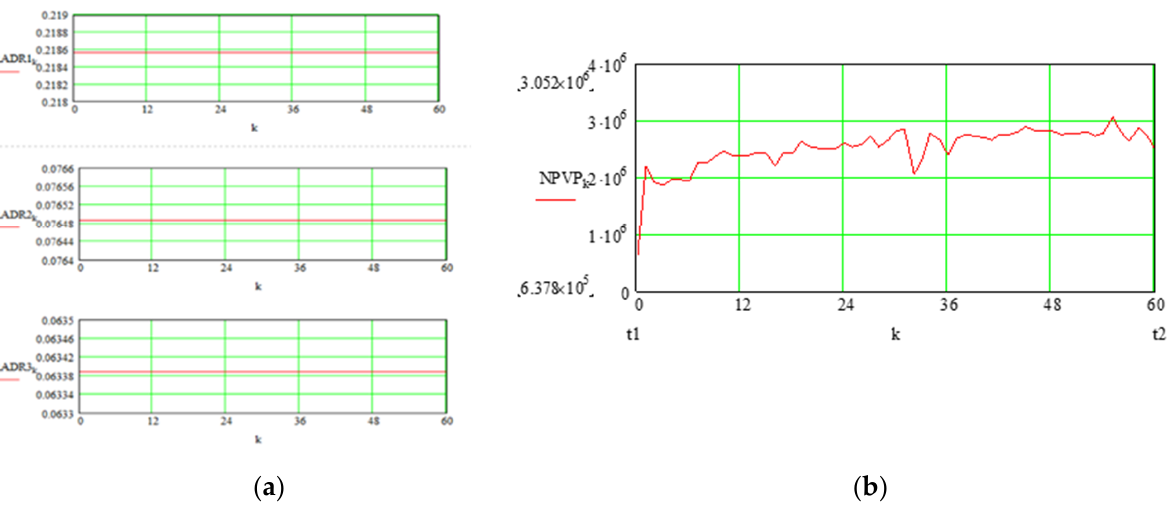
Figure 3. Graphical representation of RADR ( a ) and total NVP ( b ) dynamics during the 60 months for Scenario A (m = 1, σ = 0, interest rate term structure and fluctuations not considered).